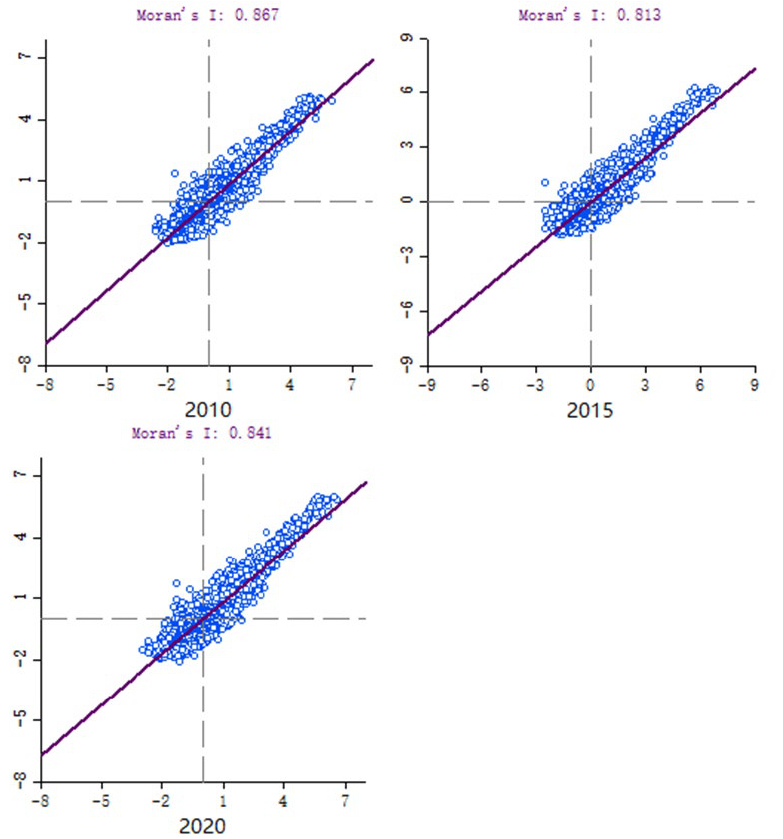
Figure 4. Ecological vulnerability Global Moran′s I scatter plot in Sh enyang in 2010, 2015 and 2020. The spatial clustering characteristics of ecological vulnerability in Shenyang were analyzed by local autocorrelation, and the LISA spatial distribution map of ecological vulnerability index in Shenyang was obtained in three periods (Figure 5). The HH ag- glomeration area accounts for 25.15%, which is concentrated in the main urban area and occurs in a row, while HH agglomeration areas also appear in Kangping County, northern Faku County, eastern Yuhong District, western Hunnan District and southern Shenbei New District, while LH agglomeration and HL agglomeration areas appear in fewer areas and account for no more than 1% of the total area, and there is little difference between the two periods in 2015 and 2020, with low and low agglomeration areas distributed in Liaozhong District, Sujiatun District and southwestern Xinmin City. The area share de- creased significantly to 21.36% and 22.34%, respectively. The high-high agglomeration area decreases compared with 2010, with 12.30% and 12.76%, respectively, mainly distributed in the main city center, eastern Yuhong District, western Hunnan District and southern Shenbei New District, while Kangping County and northern Faku County transform into insignificant areas; LH agglomeration and HL agglomeration area remain less sporadic and point-like distribution. The non-significant areas increased more, by 18.07% and 17.98%, respectively. The data from the three periods show that in Liaozhong District, Xinmin City and Sujiatun District, patches with low ecological vulnerability are spatially clustered, resulting in maintaining a low level of regional ecological vulnerability. On the contrary, the main city center, Yuhong District, Hunnan District and Shenbei New District are mainly influenced by patches with high state vulnerability, while Kangping County and Faku County are transformed from high HL clustering areas to non-significant areas, with no significant regional